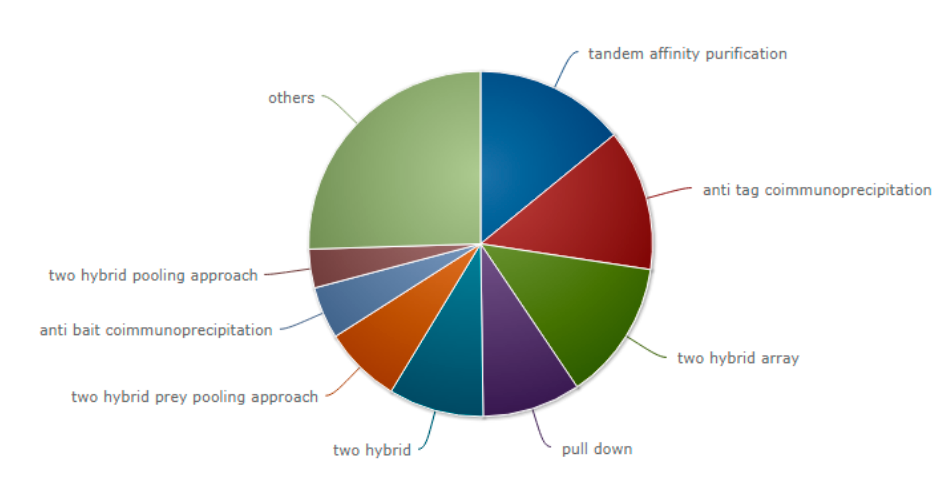
Figure 1. Interaction detection methods.